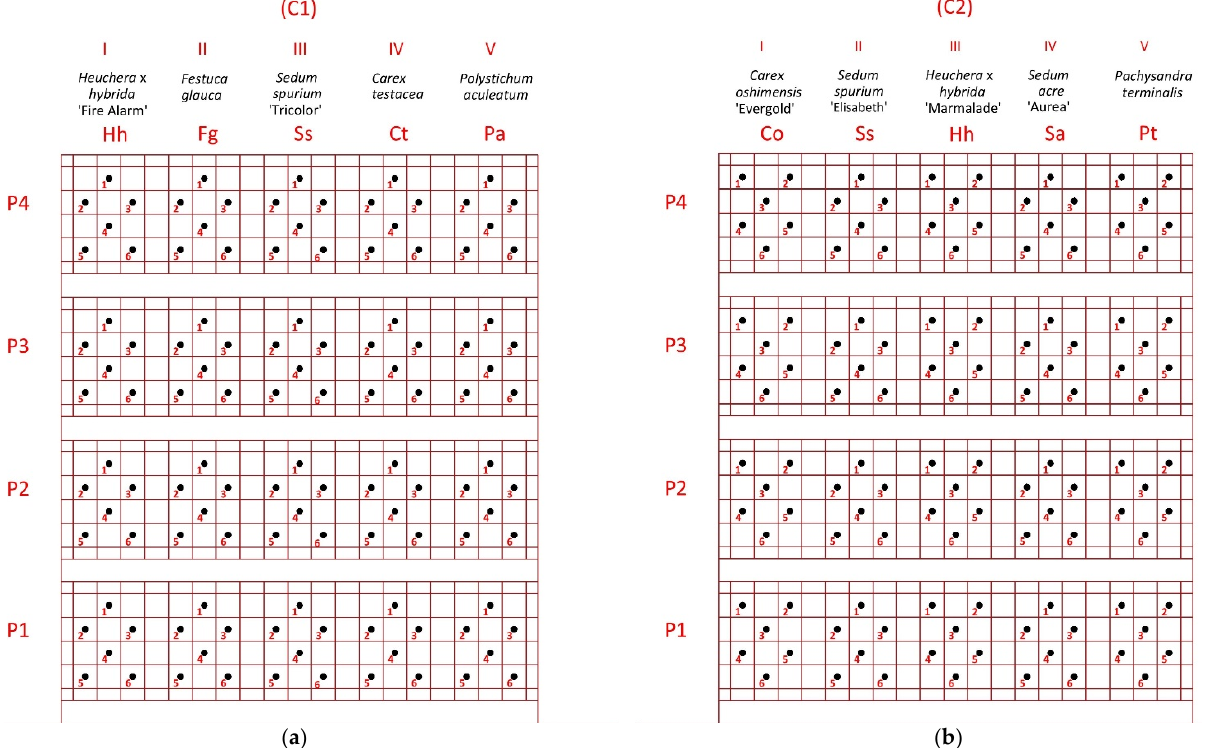
Figure 2. Planting plan of the flowering species; ( a ) species planted on the experimental structure C1; and ( b ) species planted on the experimental structure C2.